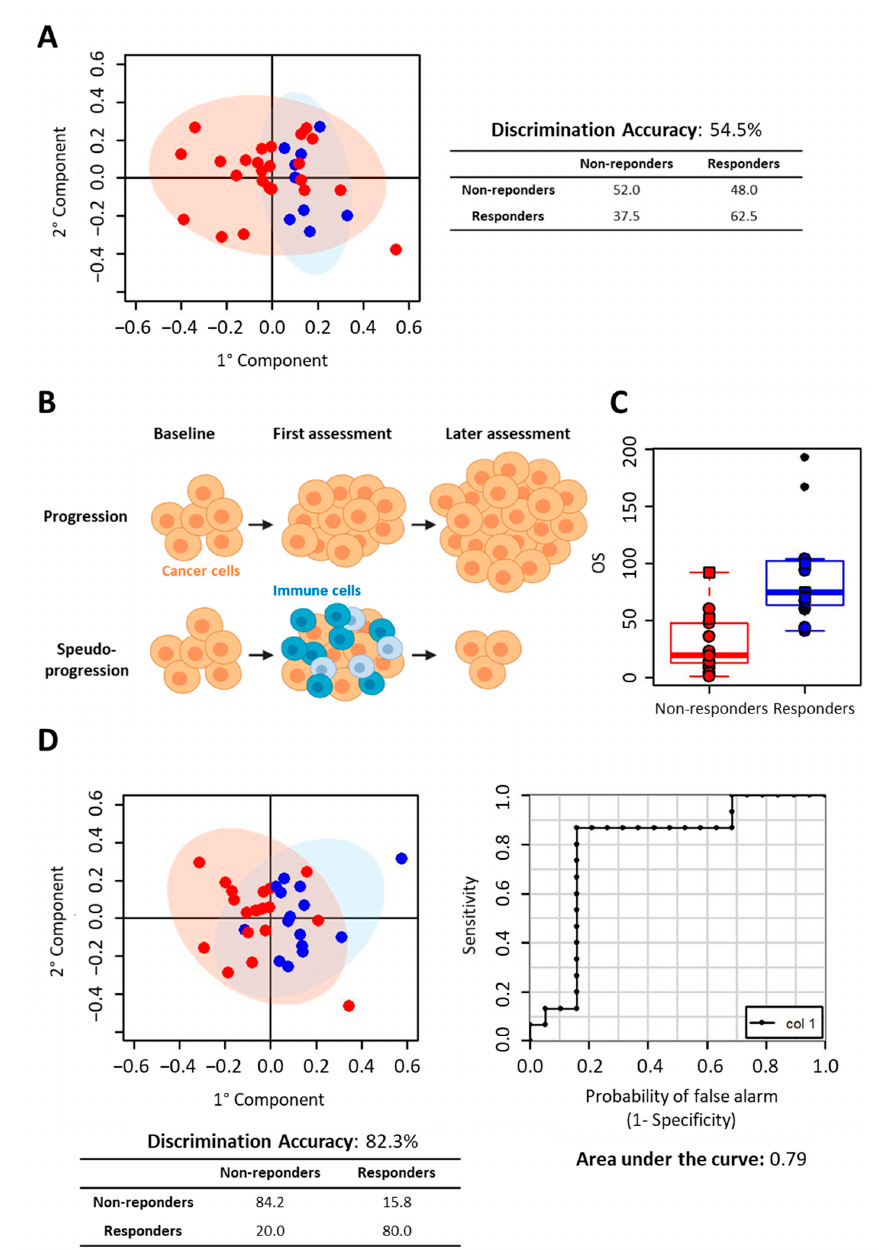
Figure 2. Prediction of Nivolumab response. ( A ) Discrimination between responders and non-responders according to the first radiological assessment. O-PLS analysis of T0 samples. Score plot, PC1 vs. PC2, and corresponding confusion matrix. Red dots: non-responder subjects; blues dots: responder subjects. ( B ) Scheme of disease progression vs. pseudo-progression in the presence of immune cells attacking the tumour. ( C ) Boxplots of OS values of the subject. Red dots: non-responder subjects; blue dots: responder subjects (subjects still on alive are marked with black dots). ( D ) Discrimination between responders and non-responders according to the second radiological assessment. O-PLS analysis of T0 serum samples. Score plot, PC1 vs. PC2, and corresponding confusion matrix (left panel); ROC curve derived from O-PLS cross-validation (right panel). Red dots: non-responder subjects; blues dots: responder subjects.